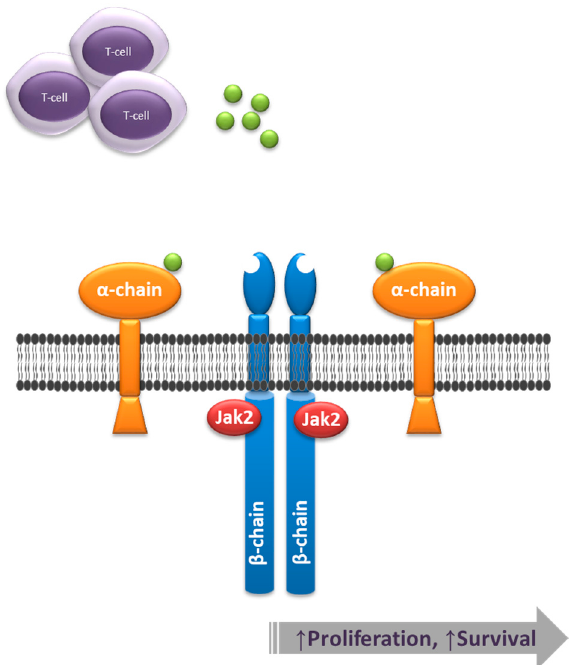
Figure 1. CD123 is the alpha chain of the interleukin 3 receptor (IL-3R). Upon ligand (green moieties) binding, the IL-3R heterodimer comprised of alpha and beta chains signals through Jak2, leading to a downstream activation of effectors that result in a net increase of cell proliferation and survival.